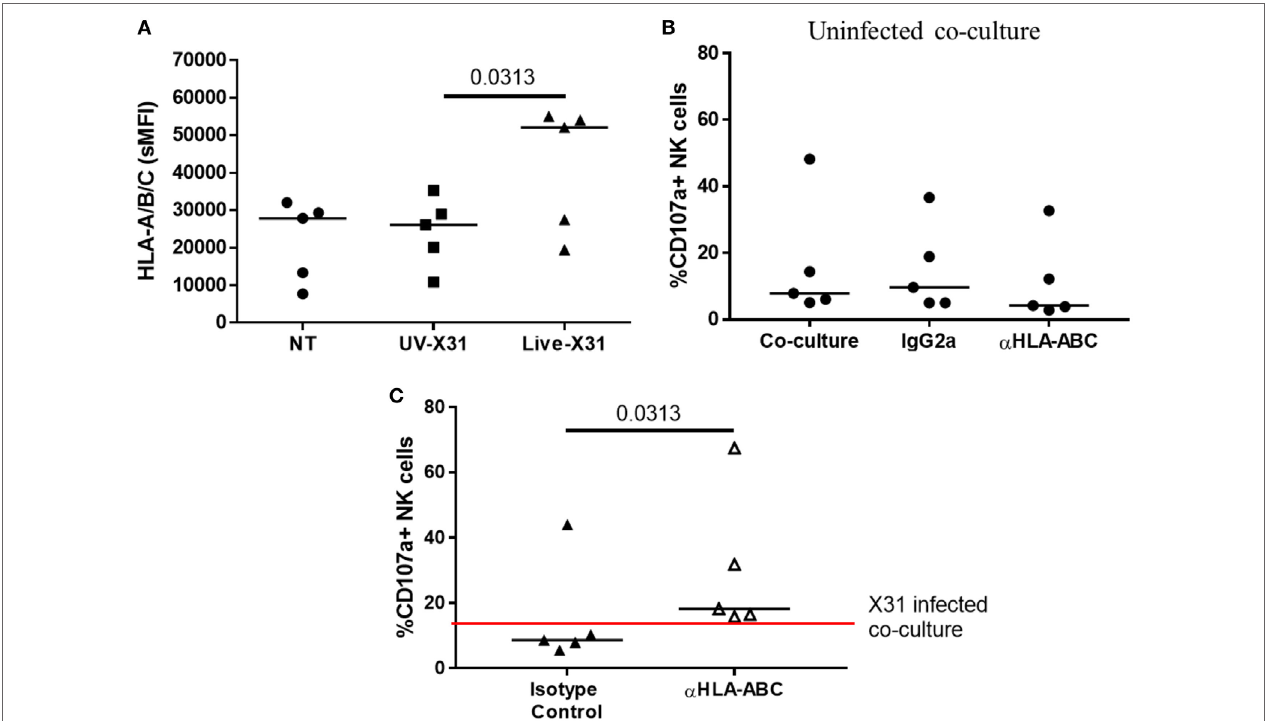
FigUre 11 | Blocking class I HLA increases natural killer (NK) cell degranulation during culture with X31-infected macrophages. (a) Monocyte-derived macrophage (MDM) HLA-A/B/C expression 24 h after uninfected (NT) UV-irradiated and live X31 infection ( N = 5). (B) Background NK cell degranulation following culture with uninfected macrophages when macrophages were treated with α HLA or isotype control for 20 min prior to addition of NK cells (IgG2a) ( N = 5). (c) 24 h post- infection MDMs were incubated with antibody against HLA-A/B/C for 20 min prior to co-culture with NK cells. NK cell degranulation was measured by flow cytometry ( N = 5). Lines describe medians. Statistical analyses performed by Wilcoxon signed-rank